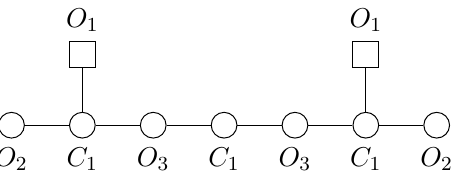
Figure 65. Quiver obtained from brane systems in the (cid:12)rst row of table 6. Its Higgs branch is M H = D 5